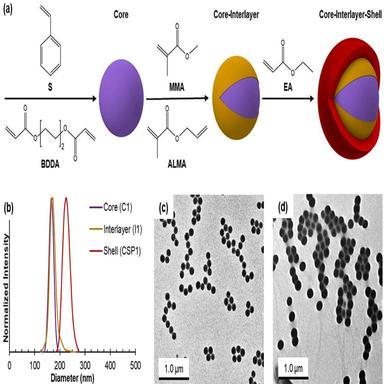
A) Synthesis scheme for the preparation of CSP via semi-continuous starved-feed emulsion polymerization. b) DLS data of the particles for individual reaction steps. c) TEM photograph of the core particles. d) TEM photograph of the final CSP particles.